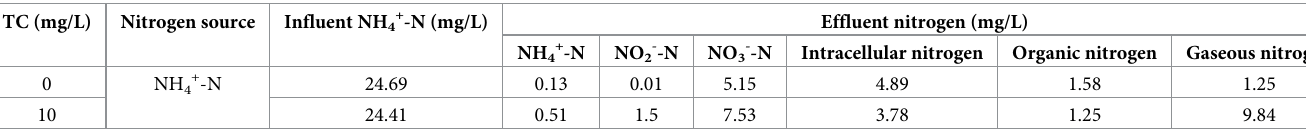
Table 3. Nitrogen balance analysis of the nitrogen removal in